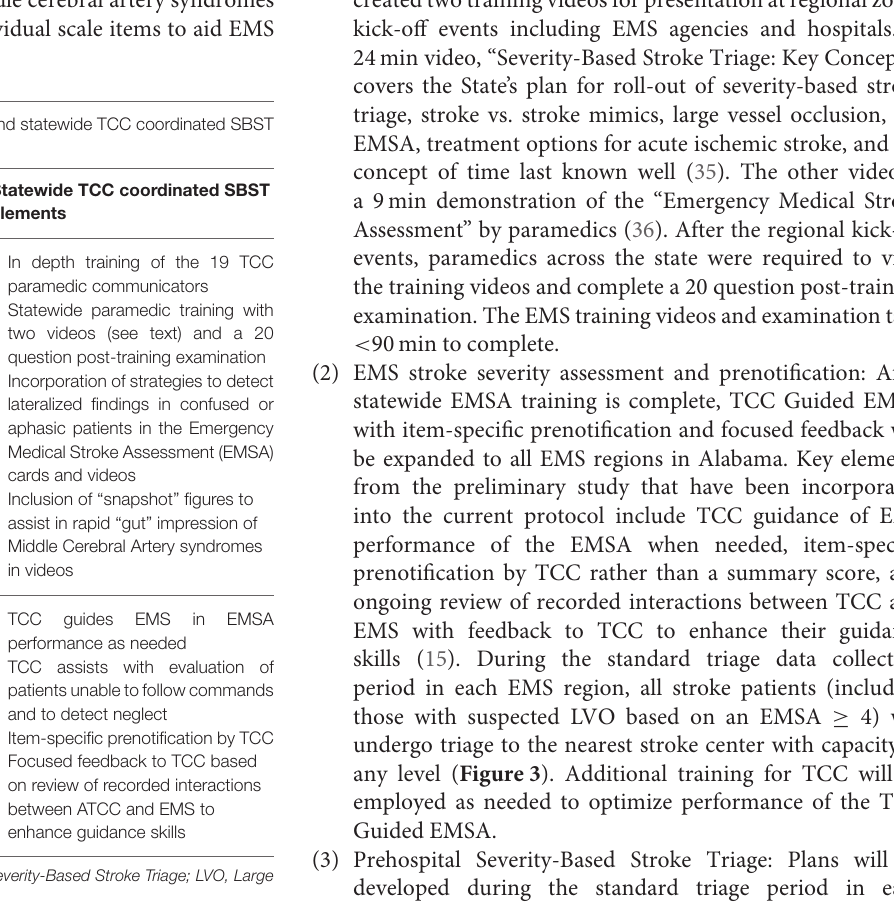
TABLE 2 | Acute stroke system challenges, TCC Coordinated SBST core functions, and examples of forms. Stroke system components and challenges Prehospital